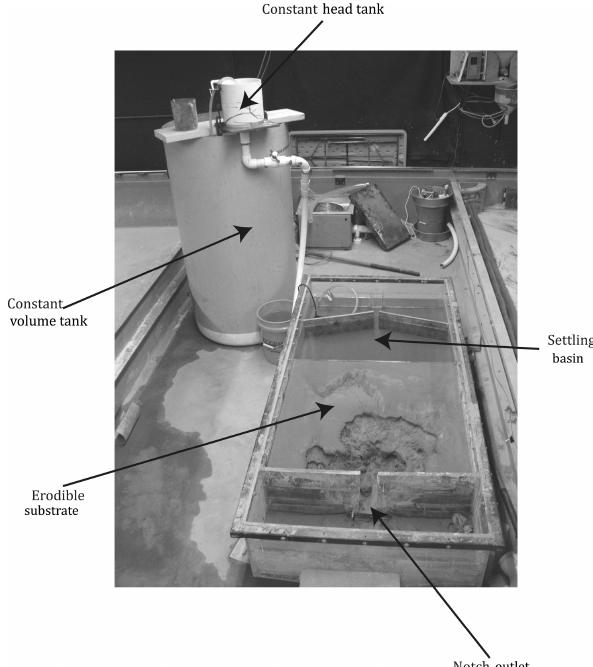
Figure 1. The experimental setup shown here allows water to flow from a settling basin over an erodible substrate and out through a 7.6 × 14cm notch. The flow rates entering the basin range from 4 × 10 − 6 to 311 × 10 − 6 m 3 s − 1 and are controlled by a constant head tank. For each run a constant volume of water either 190 or 380L is run over the erodible substrate. This figure shows the setup for the fine-grained substrate. The sand substrate setup was similar, although the erodible substrate was